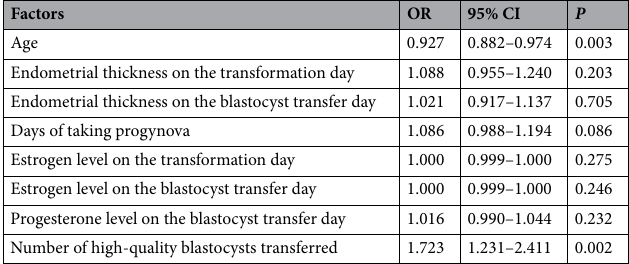
Table 6. Multivariate regression analysis for clinical pregnancy.